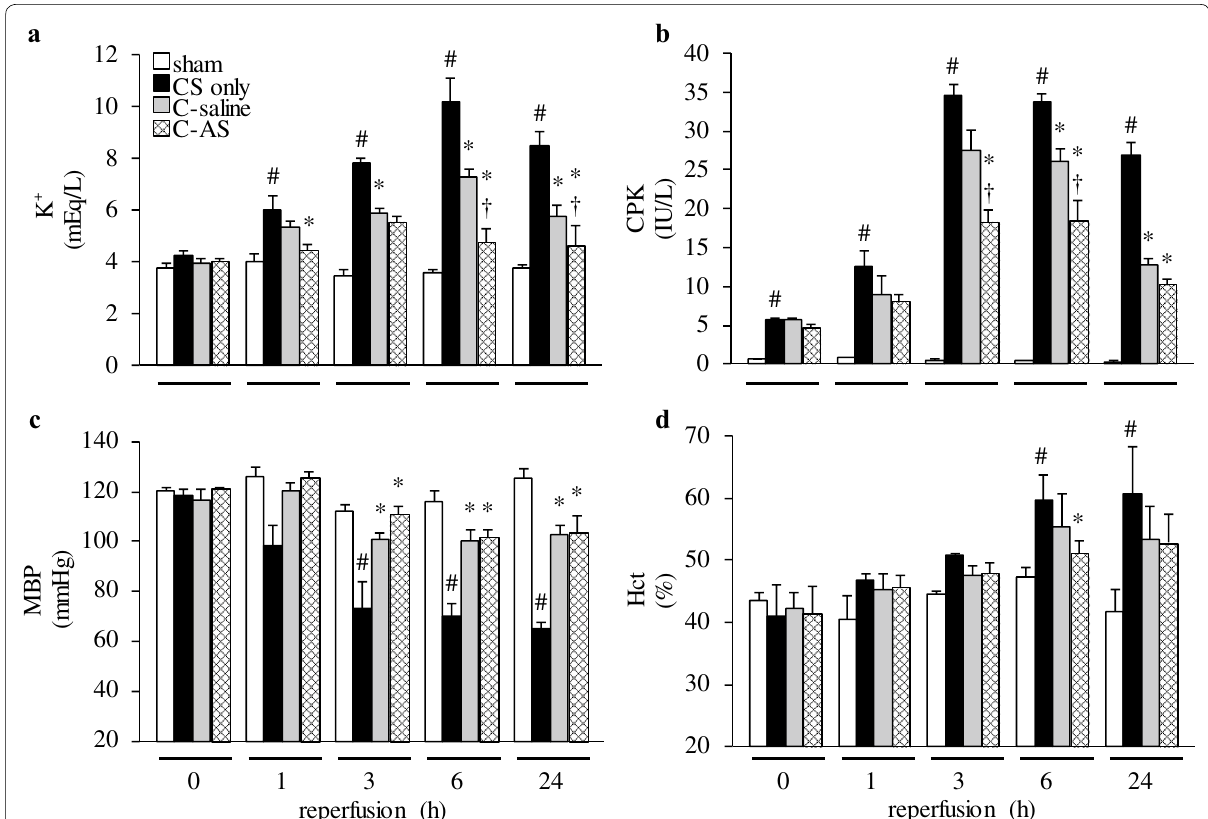
Fig. 1 Effect of fluid resuscitation on K + , CPK, MBP, and Hct levels in CS rats. a K + concentration, b CPK concentration, c MBP, and d Hct level. White bar sham, black bar CS-only, gray bar C-saline, and shaded bar C-AS. Values represent mean versus CS-only group, and † p < 0.05 versus C-saline group (Tukey’s test). CPK creatine phosphokinase, MBP mean blood pressure, Hct hematocrit, CS crush